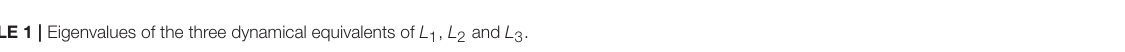
TABLE 1 | Eigenvalues of the three dynamical equivalents of L 1 , L 2 and L 3 . L